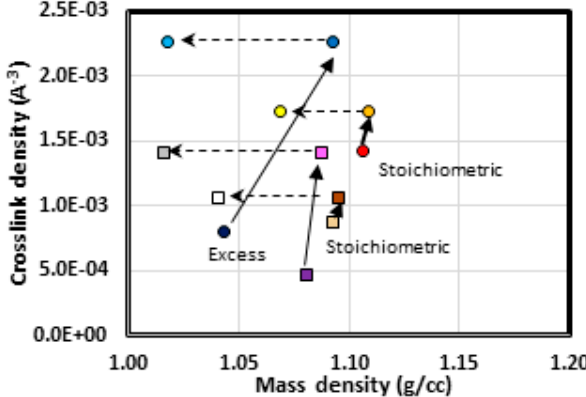
Figure 8. Crosslink density as a function of mass density. Changes due to etherification and dehydration are indicated by a solid and dashed arrows, respectively. Short- and long-chain resins are depicted by circles and squares, respectively. Stoichiometric and excess epoxide formulations are indicated.